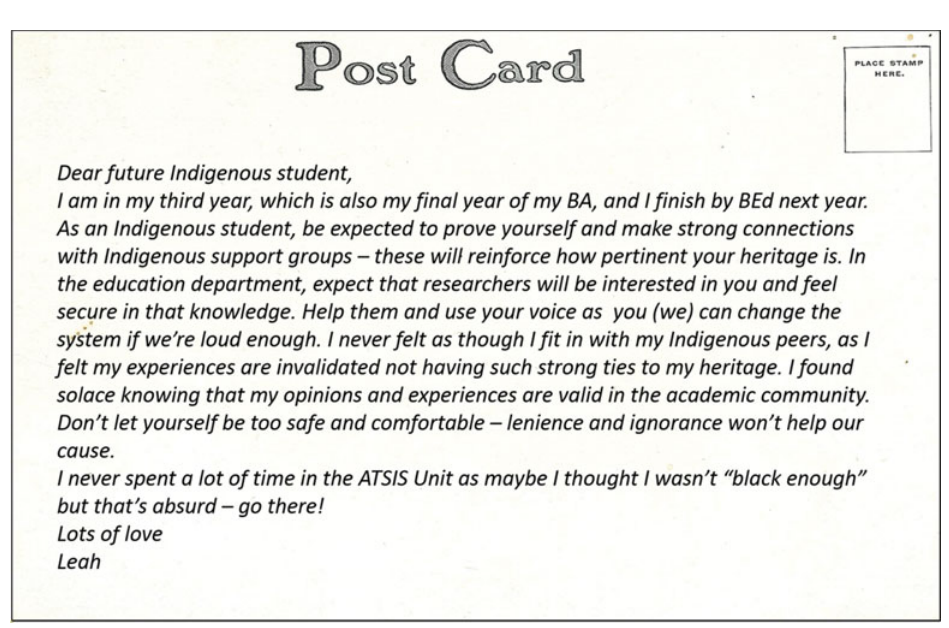
(Colour online) Leah